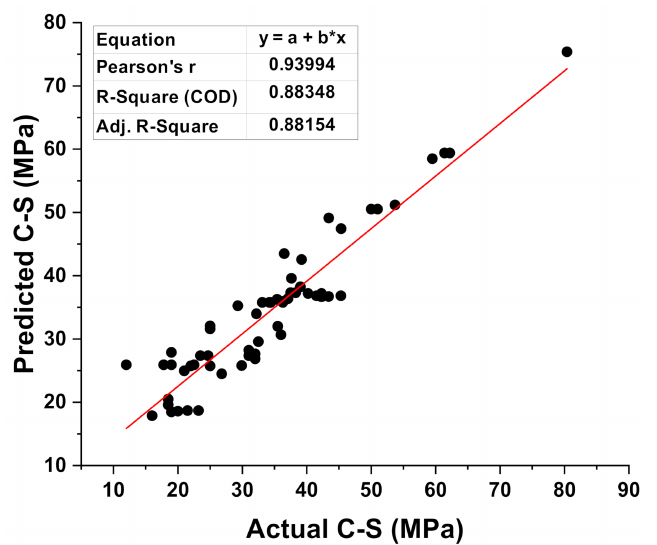
Figure 3. Correspondence between the experimental and predicted result of the MLP